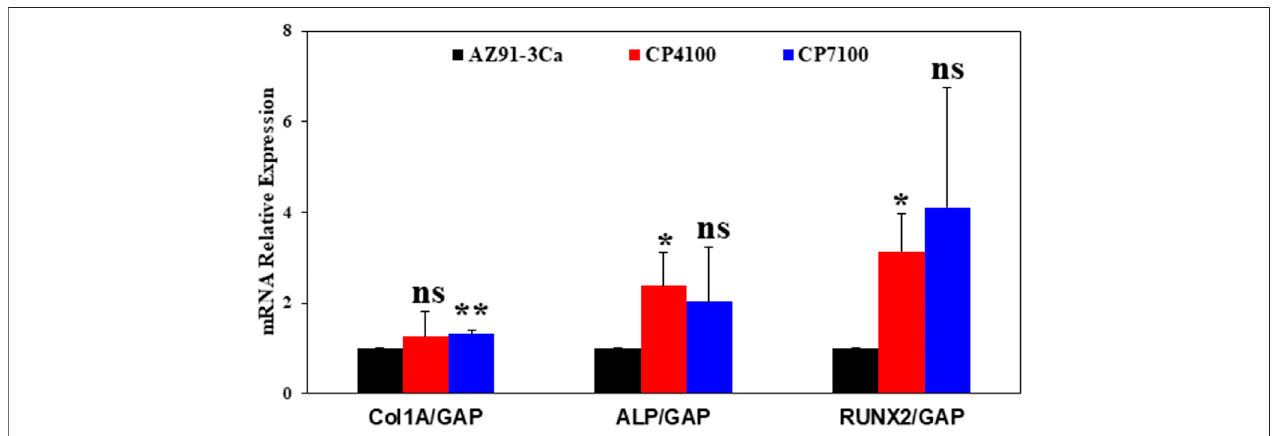
FIGURE 10 | Gene expression analysis of osteoblast differentiation and bone formation markers: Relative mRNA expression levels of Col1A, ALP and RUNX2. GAPDH was used as loading control. Values were expressed as mean ± SD ( n (cid:2) 4, each). * p ≤ 0.05 vs. control